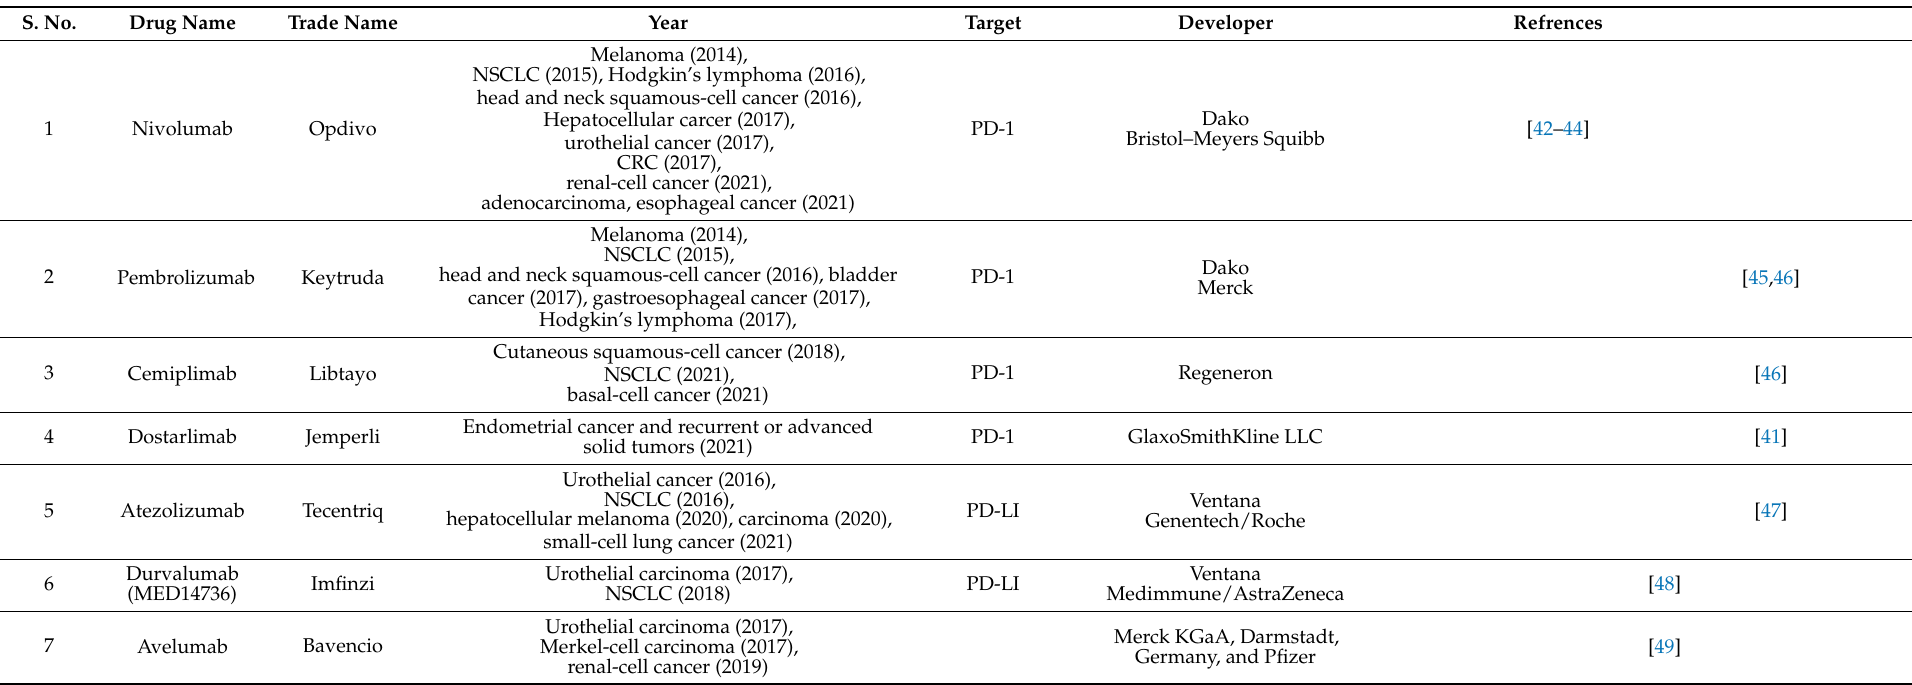
Table 1. FDA-approved PD-1/PD-L1 immune